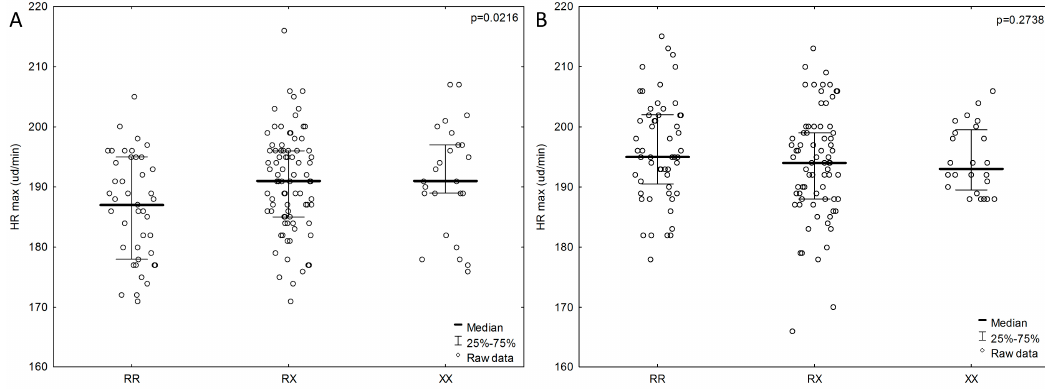
Figure 3. Association of HRmax with ACTN3 gene polymorphism in the female group ( A ) and male group ( B ). P values from ANOVA (analysis of variance) Kruskal-Wallis test .